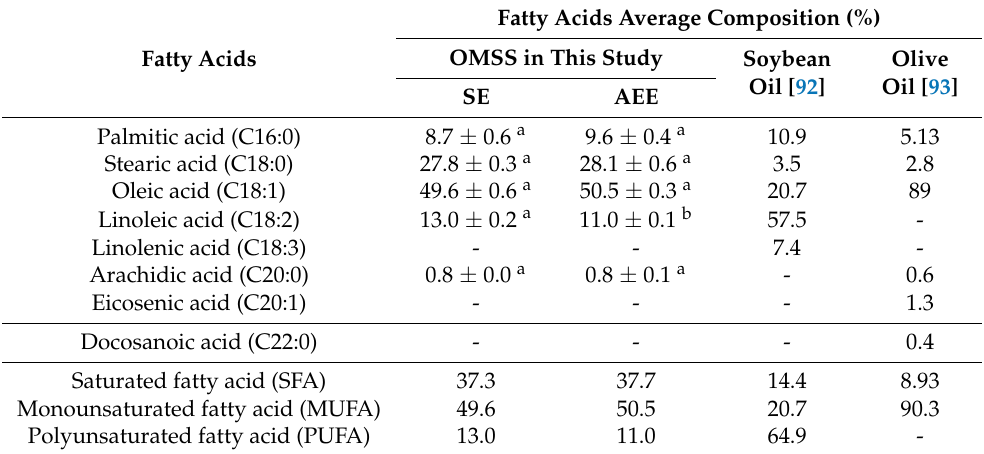
Table 4. Fatty acid composition of OMSS obtained by aqueous enzymatic extraction (AEE) and solvent extraction (SE), in comparison with soybean and olive oils.